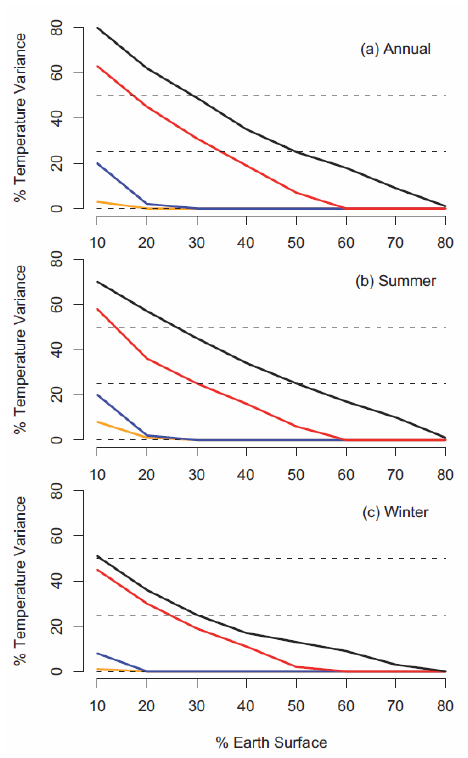
Figure 9: Percentage of Earth surface (on x-axis) where the variances of the signatures of the forcings used in SGI explain at least the percentage of temperature variance represented on y-axis. This diagnostic is represented for solar (red line), CO 2 (blue line) and orbital (orange line) forcing and for all the forcings together (black line). The horizontal dashed lines underline 25 and 50% of temperature variance.